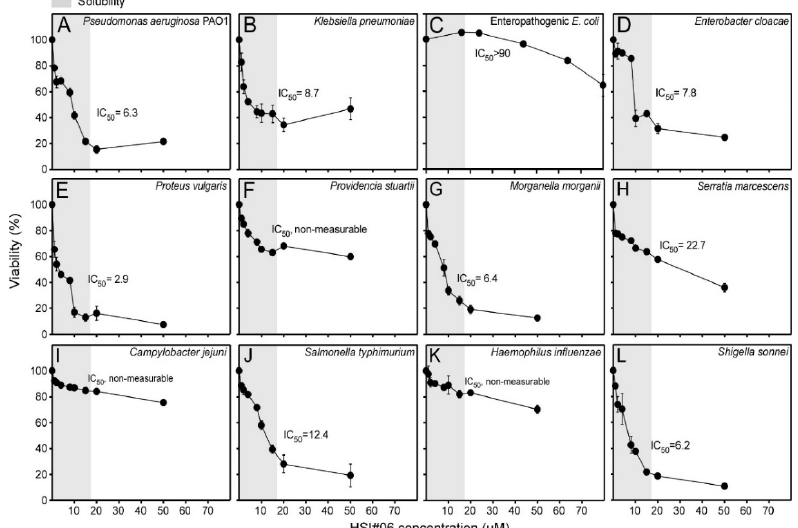
Figure 4. Antibacterial activity of secretion inhibitors toward 12 Gram-negative bacteria from the WHO’s top 16 pathogens list. ( A )–( L ). The indicated inhibitors which revealed inhibition of Gram-negative bacterial viability. The growth of the indicated bacterial strains (as in Figure 2B) was plotted against the inhibitor concentration. IC 50 values for growth inhibition of the bacteria are indicated. Growth in the presence of 2.5% (v/v) dimethyl sulfoxide in the absence of inhibitors was taken as 100%. n = 3 . The results are presented as the mean ± SD. Gray shade: aqueous solubility. Table 2. Priority pathogens list for R&D of new antibiotics. Adjusted from the WHO 2018 recommendation list [41].